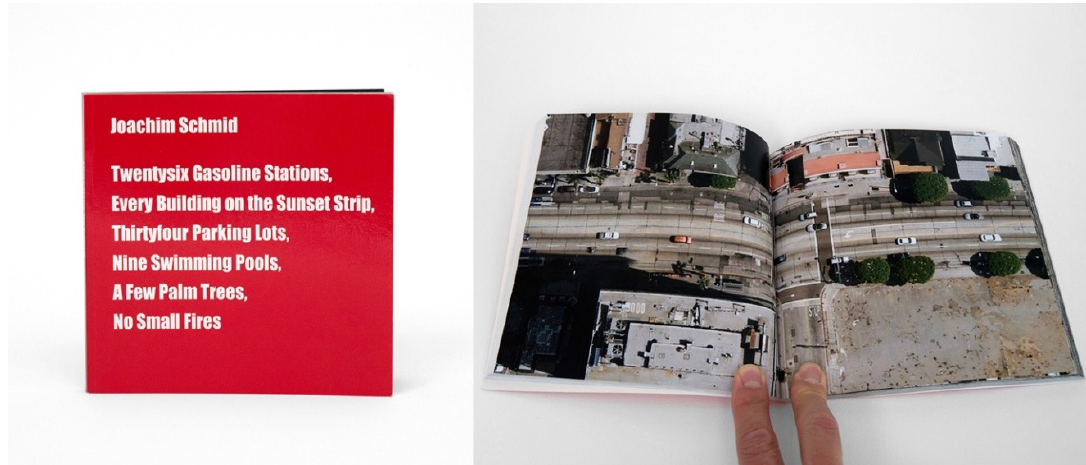
Figure 18. Joachim Schmid, Twentysix Gasoline Stations, Every Building on the Sunset Strip, Thirtyfour Parking Lots, Nine Swimming Pools, A Few Palm Trees, No Small Fires , 2009.